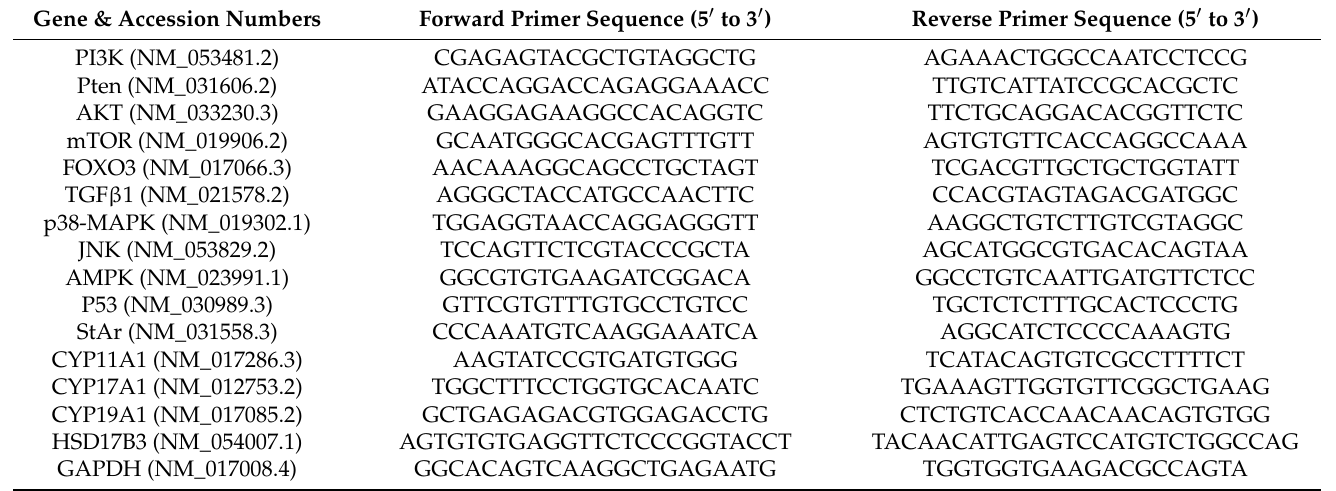
Table 1. Forward and reverse primers sequence of targeted